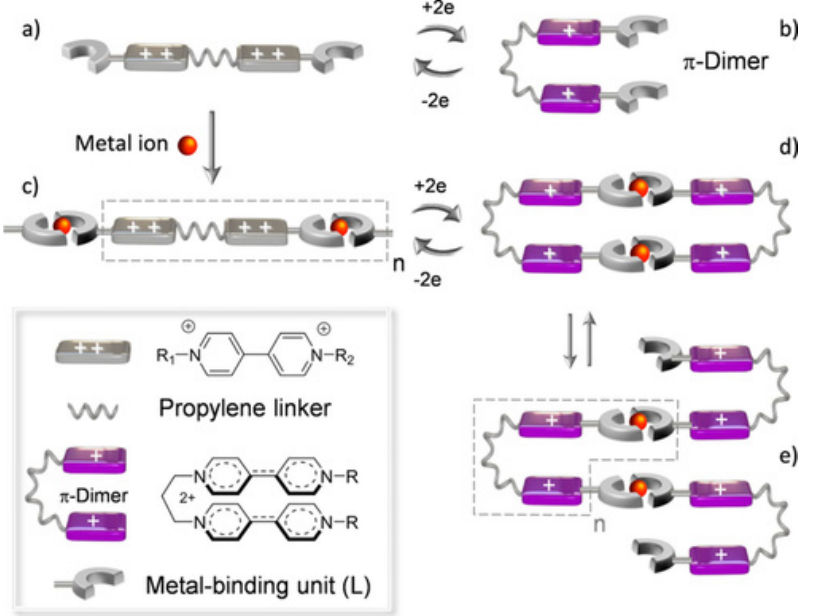
Figure 6. Schematic illustration of eclectically driven reversible extension to folding conformational change in the absence ( a , b ) and in the presence ( c – e ) of metal ion. Two possible folding structures ( d , e ) were available in the association and/or the organization of tectons within metal-ligand assemblies upon the electric stimuli. Reprinted with permission from Ref. [46]. Copyright 2018, Wiley-VCH Verlag GmbH and Co.